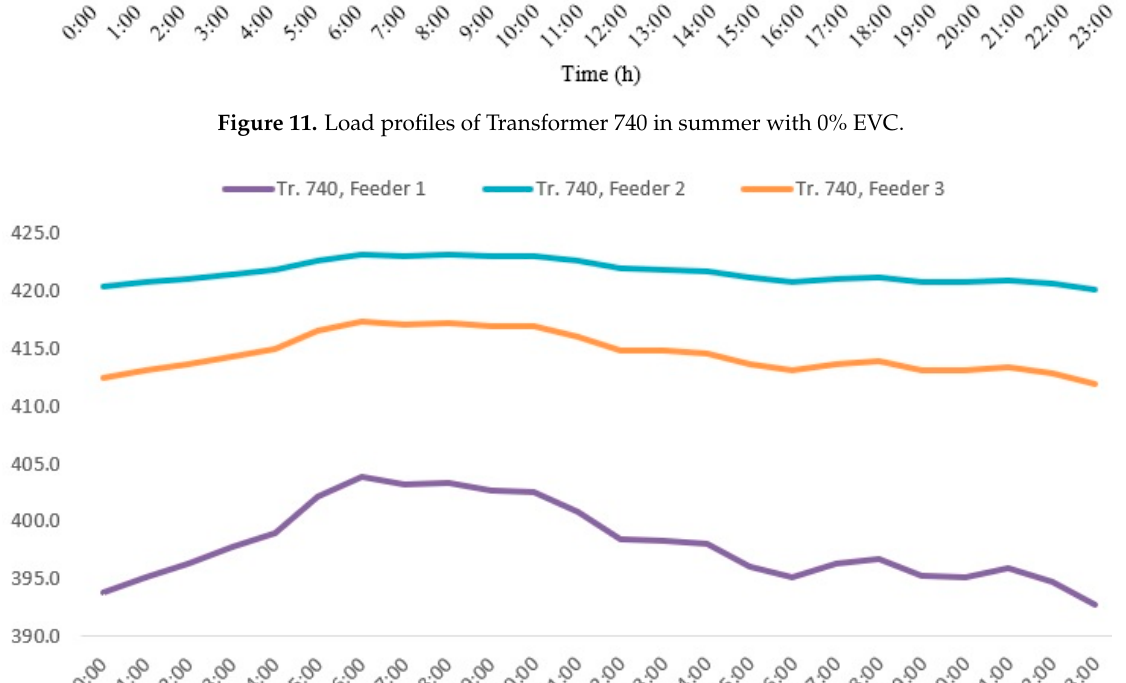
Figure 13. Load profiles of Transformer 740 in summer with 60% EVC.